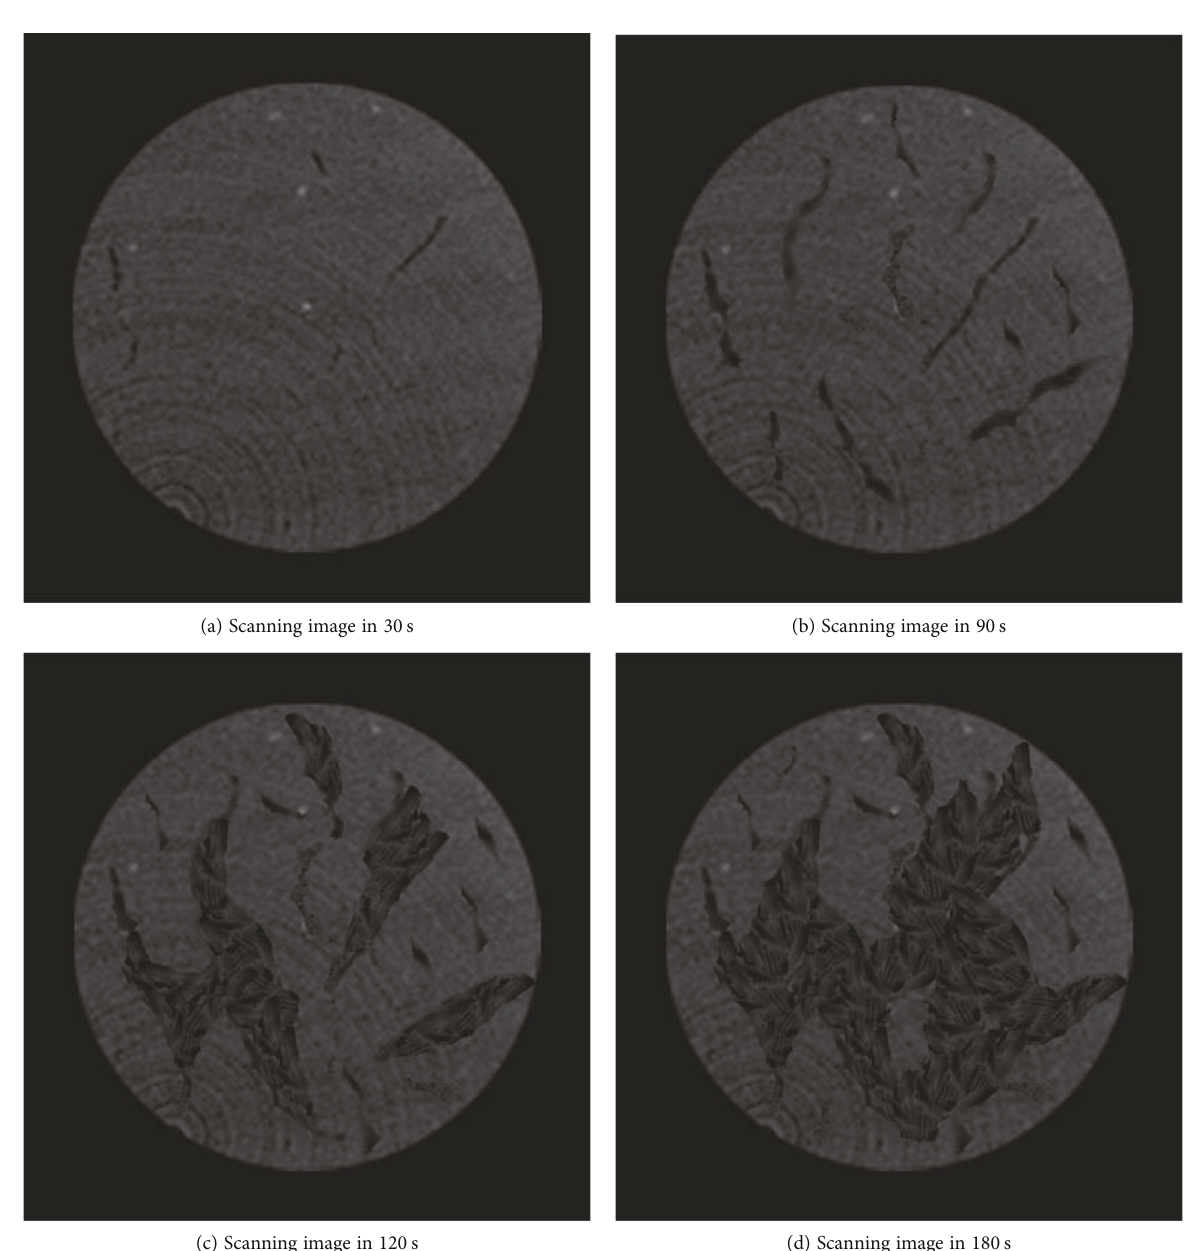
Figure 6: The fracture distribution images of CT scan